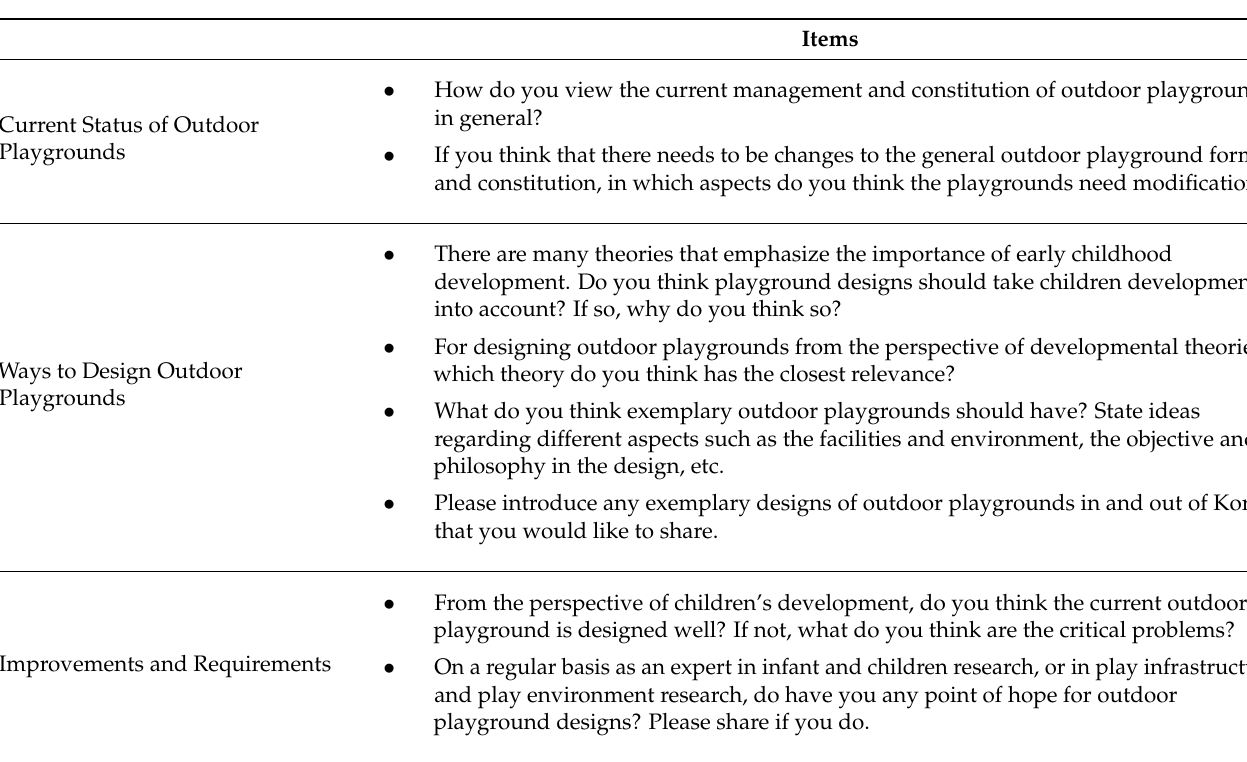
Table A1. Questions for the In-depth Interview.